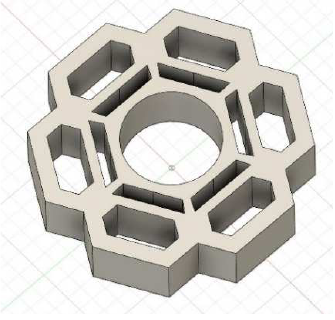
Figure 5. Polyhedral unit cell (8 × 8 × 2 mm 3 ).